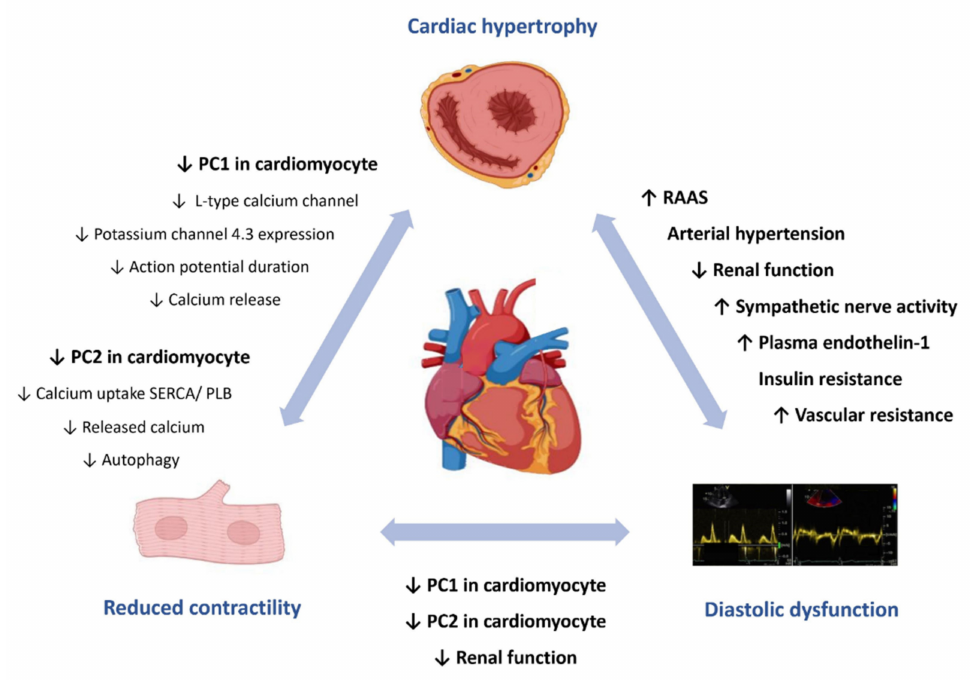
Figure 1. Autosomal dominant polycystic kidney disease and the heart. Current understanding of pathophysiological mechanisms underlying cardiac involvement in autosomal dominant